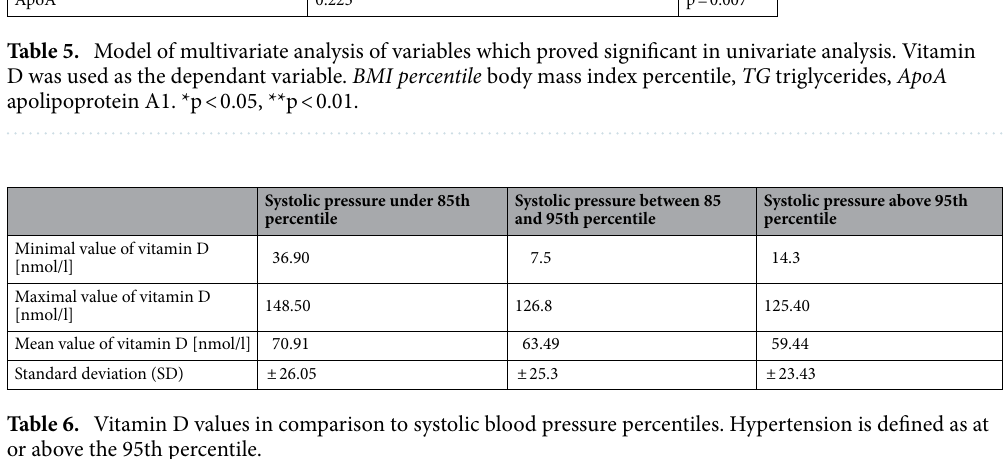
Table 6. Vitamin D values in comparison to systolic blood pressure percentiles. Hypertension is defined as at or above the 95th percentile.